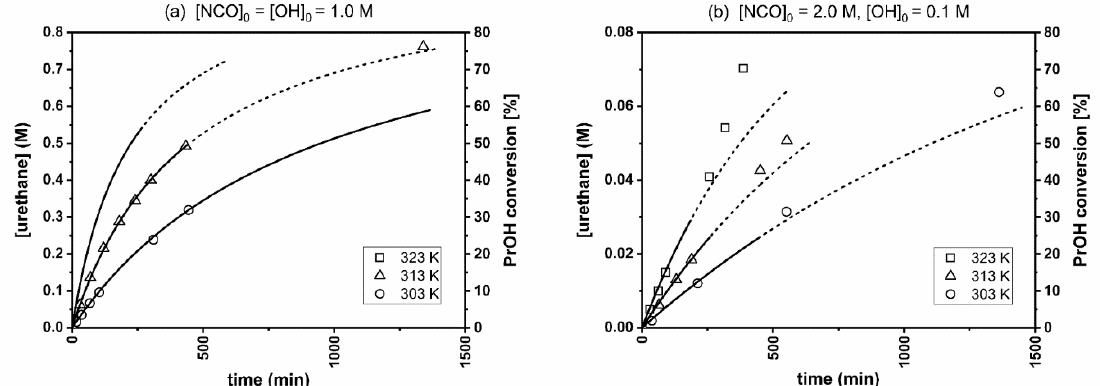
Figure 2. Experimental kinetic curves. ( a ) Second-order kinetics for the stoichiometric ratio. ( b ) pseudo first-order kinetics for the 20-fold PhNCO excess. Data points used for fitting and reaction rate constants’ determinations are indicated by solid curve segments.